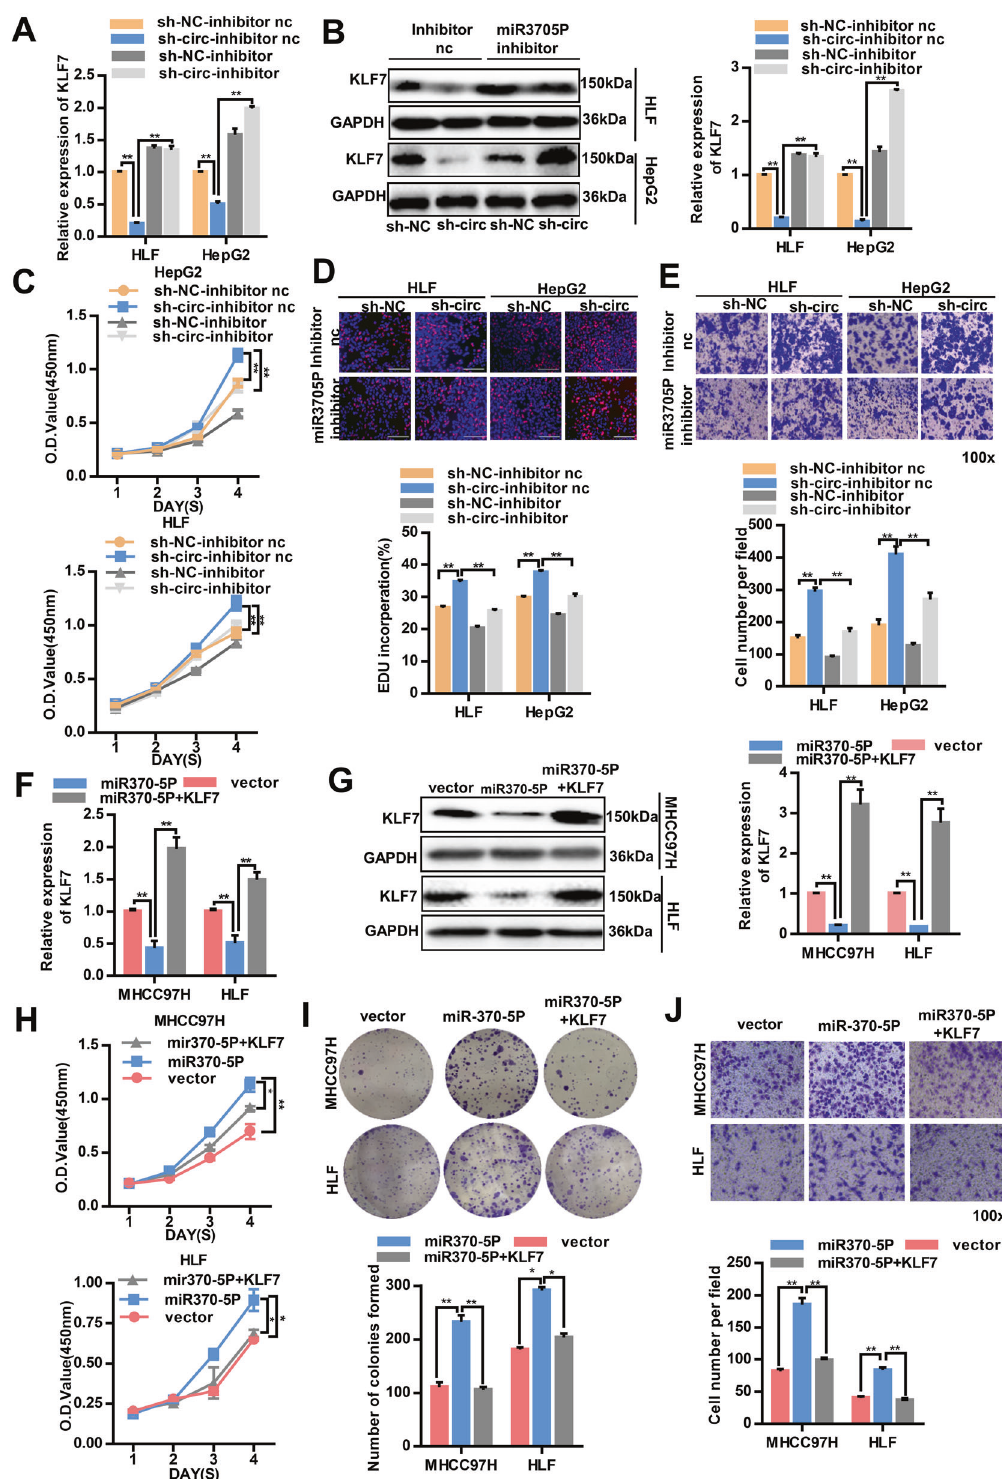
Fig. 8 CircUBE2J2 inhibited HCC progression through the circUBE2J2/miR-370-5p/KLF7 axis. A KLF7 expression in the mRNA level was measured by qPCR in HCC cells after circUBE2J2 knockdown. B After circUBE2J2 knocking down, miR-370-5P inhibitor or inhibitor nc were added to HLF and HepG2 cell culture. The KLF7 protein expression level was analyzed by western blot. C The cell proliferation in HCC cells with the reduced expression of miR-370-5P was assessed by a CCK-8 assay. D The proliferation ratio of HCC cells was measured by EdU incorporation. E The migration abilities in HCC cells with the reduced expression of miR-370-5P were evaluated via a transwell assay. F After miR-370-5P overexpression, KLF7 overexpression vector was added to MHCC97H and HLF cell culture. KLF7 expression in the mRNA level was measured by qPCR. G The KLF7 protein expression level was analyzed by western blot. H The cell proliferation in HCC cells was assessed by a CCK-8 assay. I Colony formation assays show the proliferation. J Transwell migration assays. Data are presented as mean ± SD, n = 3. * p < 0.05, ** p < 0.01; NS no signi fi cance. sh-circ transfected with lentivirus for circUBE2J2-speci fi c shRNA; sh-NC transfected with control lentivirus. Cell Death and Disease (2021)